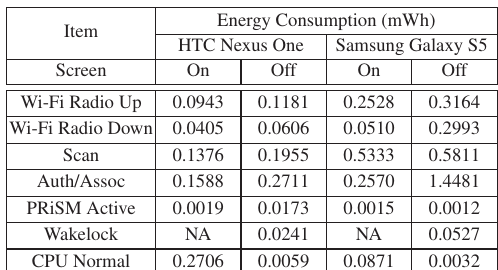
Figure 9: (a) Average ρ FP and ρ FN for users in dataset ‘D1’ and (b) ρ FP and ρ FN for 5 consecutive days for a user.